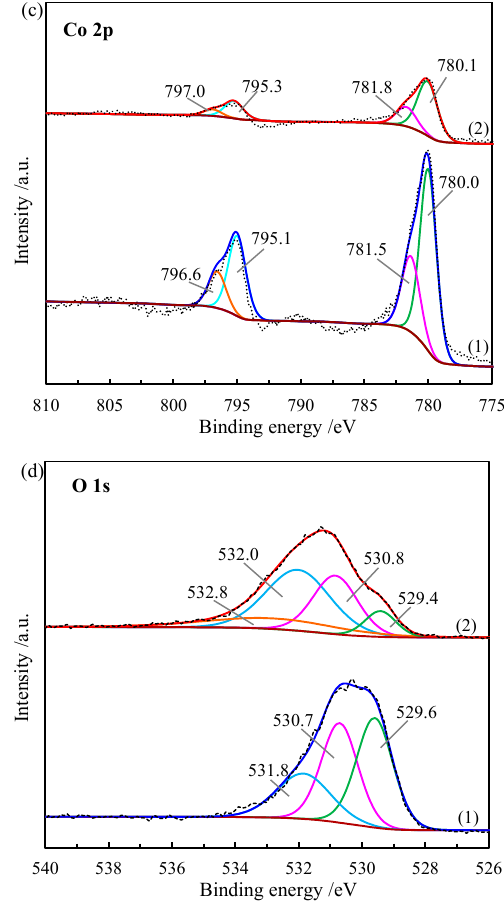
Figure 4. ( a ) XPS survey spectra of (1) pure CoOOH and (2) CoOOH/rGO. ( b ) C 1s spectra of CoOOH/rGO. ( c ) Co 2p spectra and ( d ) O 1s spectra of (1) pure CoOOH and (2) CoOOH/rGO.